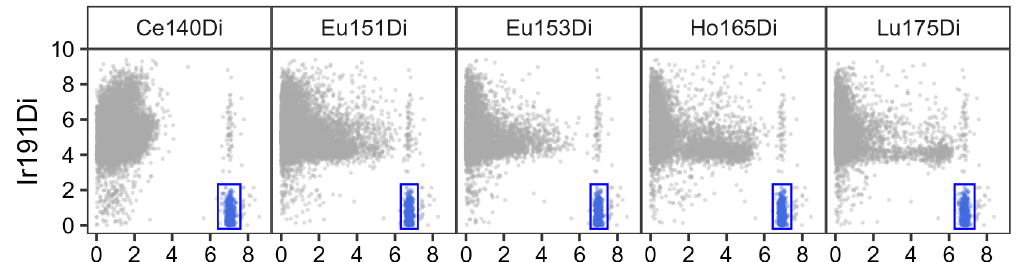
Figure 2. Scatter plots for bead channels vs. DNA. Events identified as beads are colored in blue; for each bead channel, expression ranges across all bead events are indicated as rectangular gates. Events were downsampled to at most 10,000 for